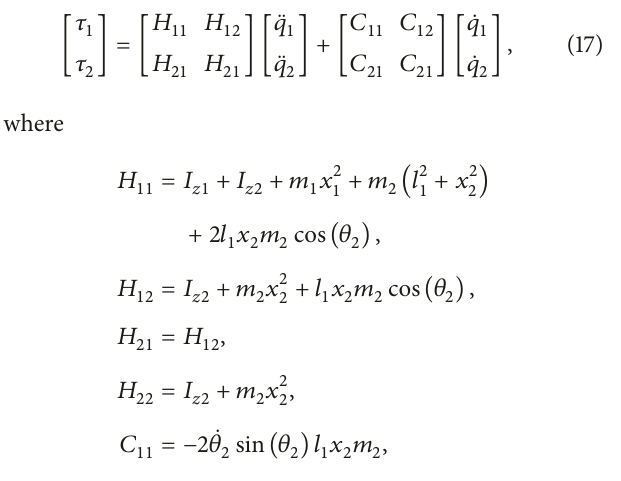
where 𝑚 is the all weight of robot arm including fermenting grains and g and a are gravitational acceleration and transla- tional motion acceleration of robot arm along the 𝑧 -axis.